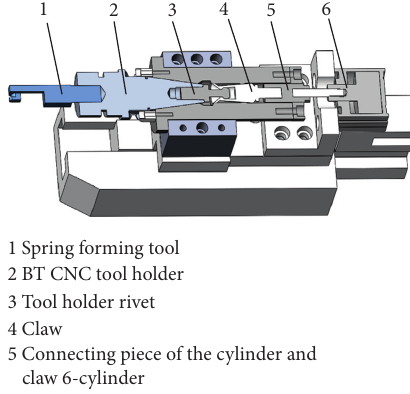
Figure 3: Schematic diagram of the cross-section of the automatic loose-clamp